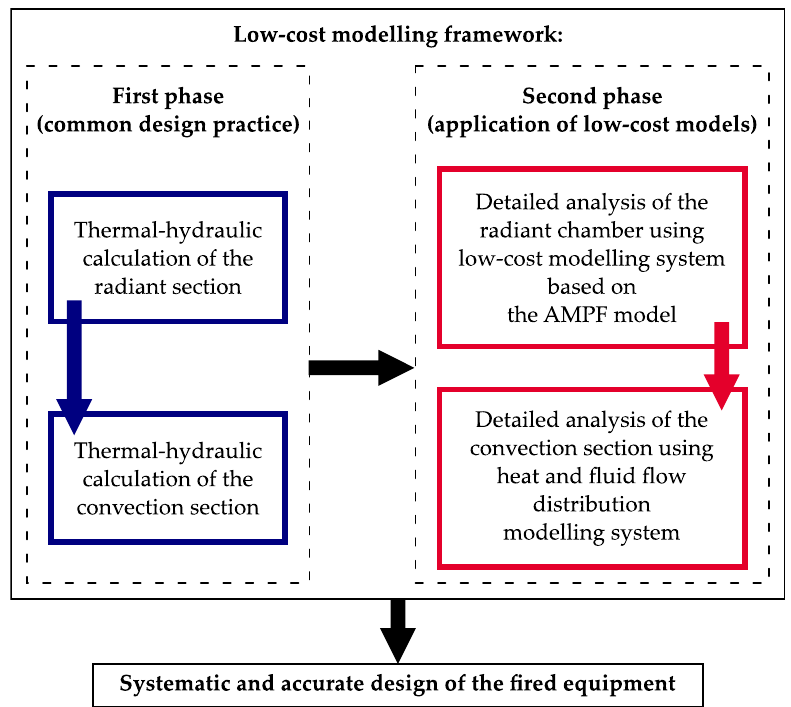
Figure 3. Proposed systematic framework of the novel design procedure showing the interconnection between all calculations